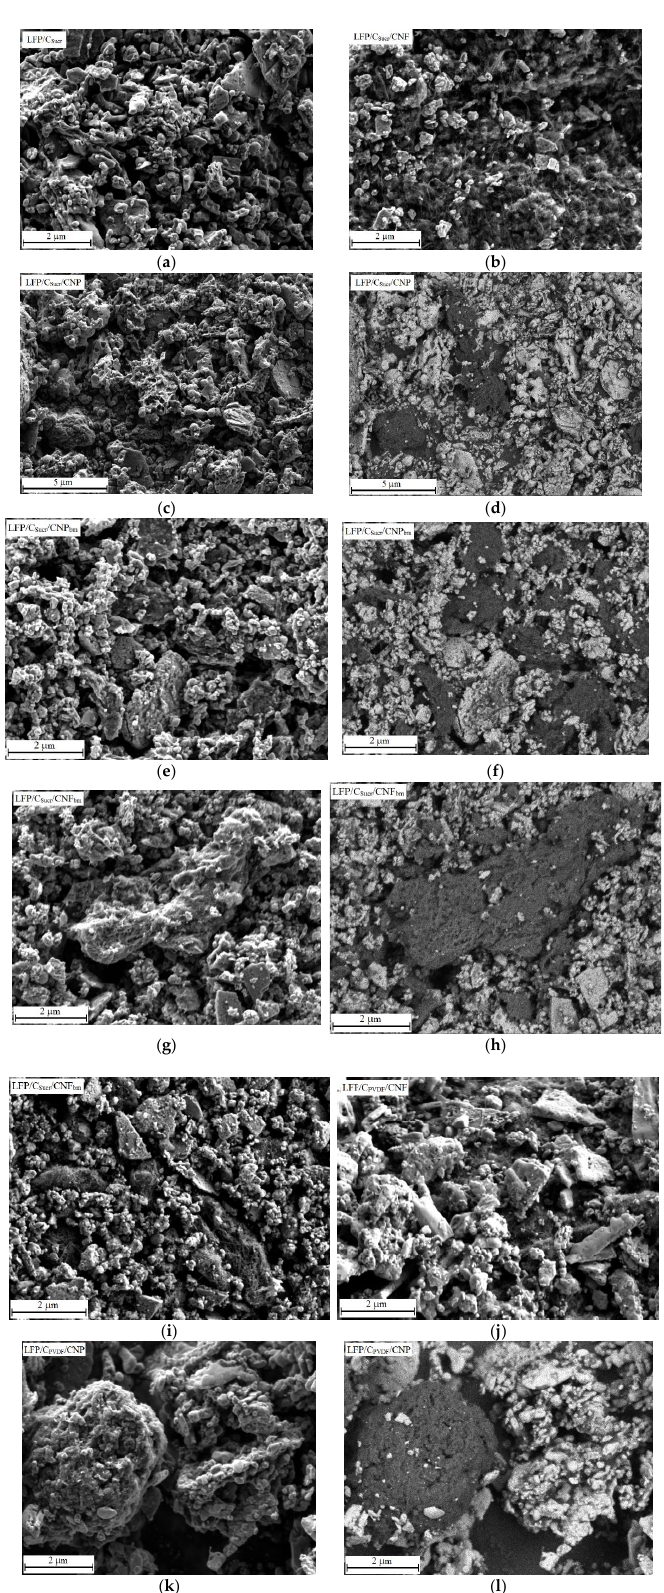
Figure 2. SEM images of the LFP/C Sucr ( a ), LFP/C Sucr /CNF ( b ), LFP/C Sucr /CNP ( c , d ), LFP/C Sucr /CNP bm ( e , f ), LFP/C Sucr /CNF bm ( g – i ), LFP/C PVDF /CNF ( j ), and LFP/C PVDF /CNP ( k , l ) samples. ( a – c , e , g , i – k )—secondary electron images; ( d , f , h , l )—backscattered electron images (darker